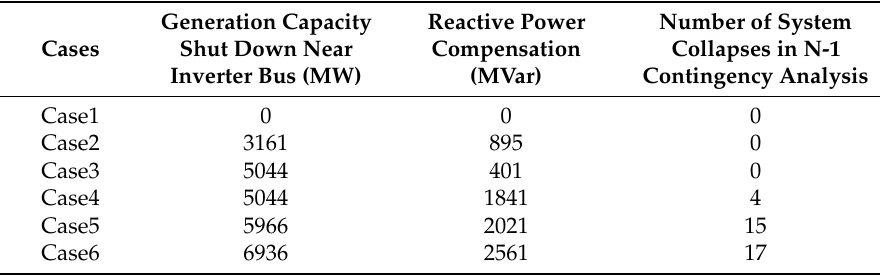
Table 5. Case Designs for the Eastern China